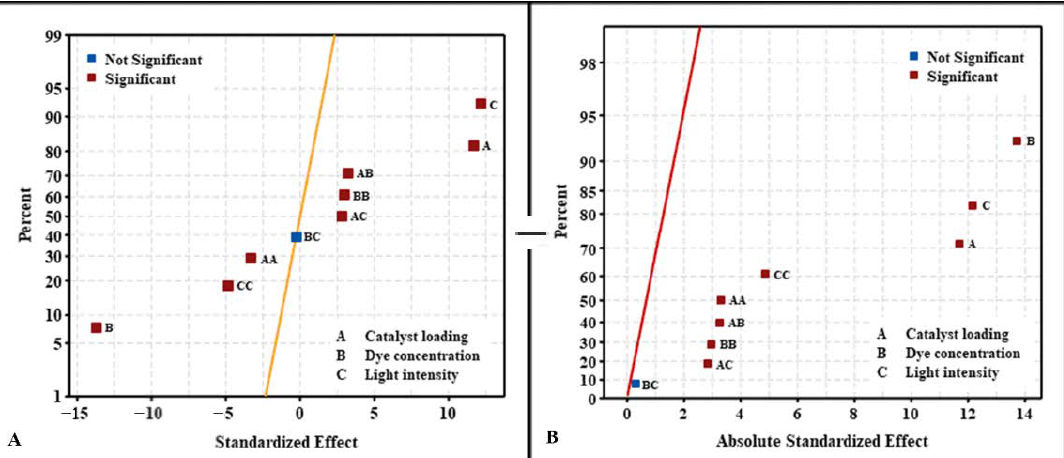
Figure 5. Normal probability plot of the residuals for DB15